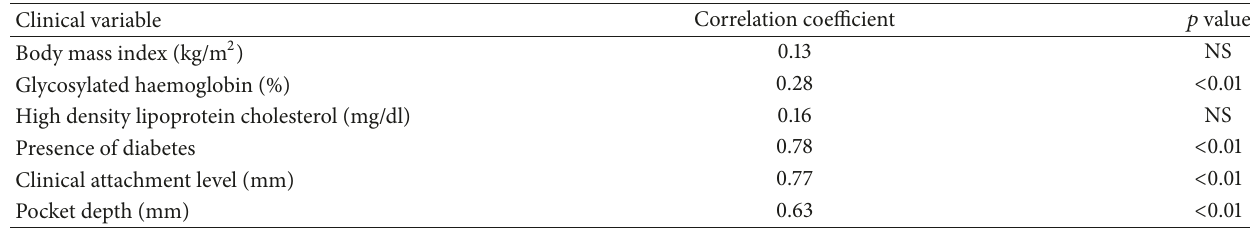
Table 3: Correlation of clinical parameters with gingival index in the study